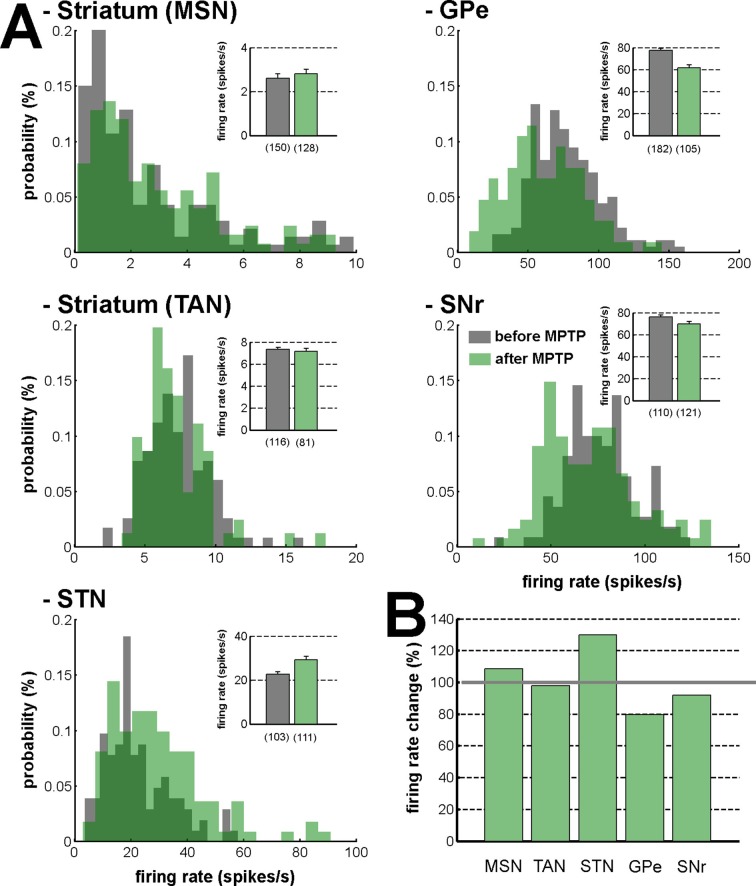
Firing rate in the BG network before and after MPTP intoxication.(A) Distribution of the firing rate of the neuronal components of the BG network. Gray - before MPTP; light green - after MPTP; dark green - overlapping bins. Inset, mean firing rate before and after MPTP intoxication. Error bars represent SEMs. Numbers in parentheses indicate the number of neurons. (B) Percentage of change in the firing rate after MPTP intoxication, for the neuronal components of the BG network. Gray line (100%) represents the healthy (before MPTP) firing rate.